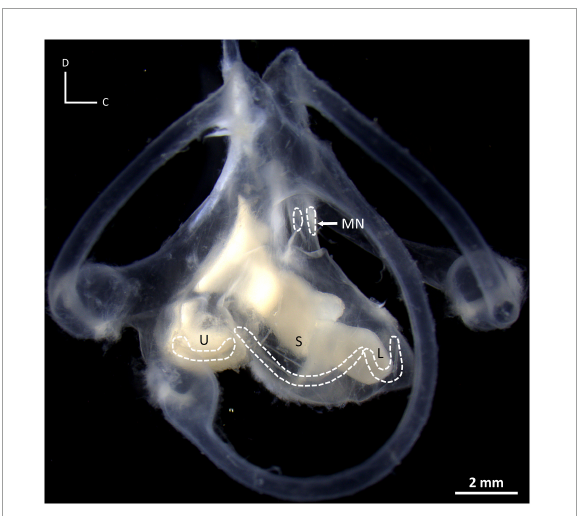
FIGURE1 Photograph of the inner ear of a New Zealand carpet shark, Cephaloscyllium isabellum , illustrating the saccule (S), lagena (L), utricle (U), and macula neglecta (MN), and their associated maculae (dashed outlines). Note the maculae do not lie in the same plane in three-dimensional space. D , dorsal; C ,